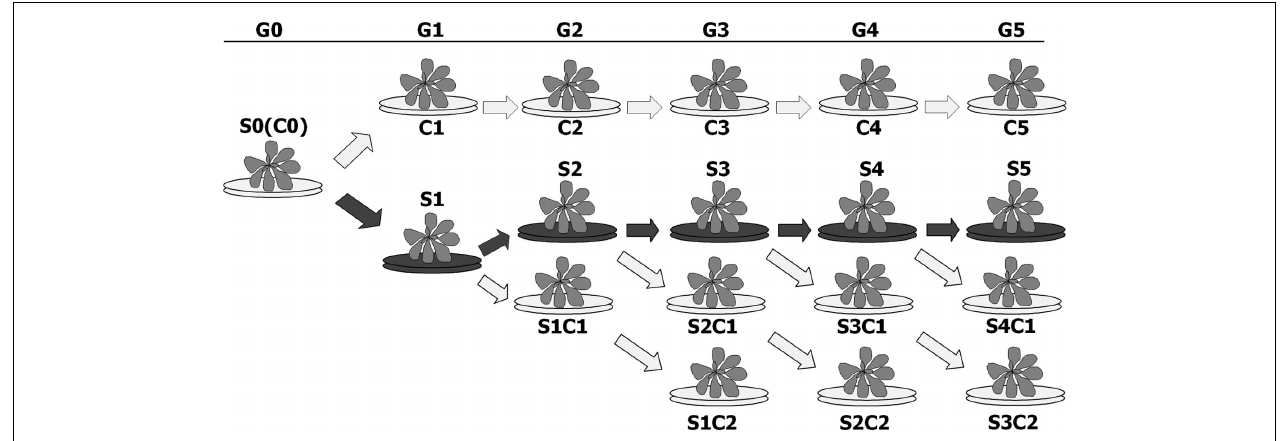
presence or absence of heavy metals, giving rise to S3, S2C1, and S1C2 plants. G3 plants (S3, S2C1, and S1C2) were propagated to the next generation (G4) in presence or absence of heavy metals, giving rise to S4, S3C1, and S2C2 plants. G4 plants (S4, S3C1, and S2C2) were propagated to the next generation (G5) in presence or absence of heavy metals, giving rise to S5, S4C1, and S3C2 plants.The control plants were propagated for five generations without stress exposure, giving rise to C1, C2, C3, C4, and C5